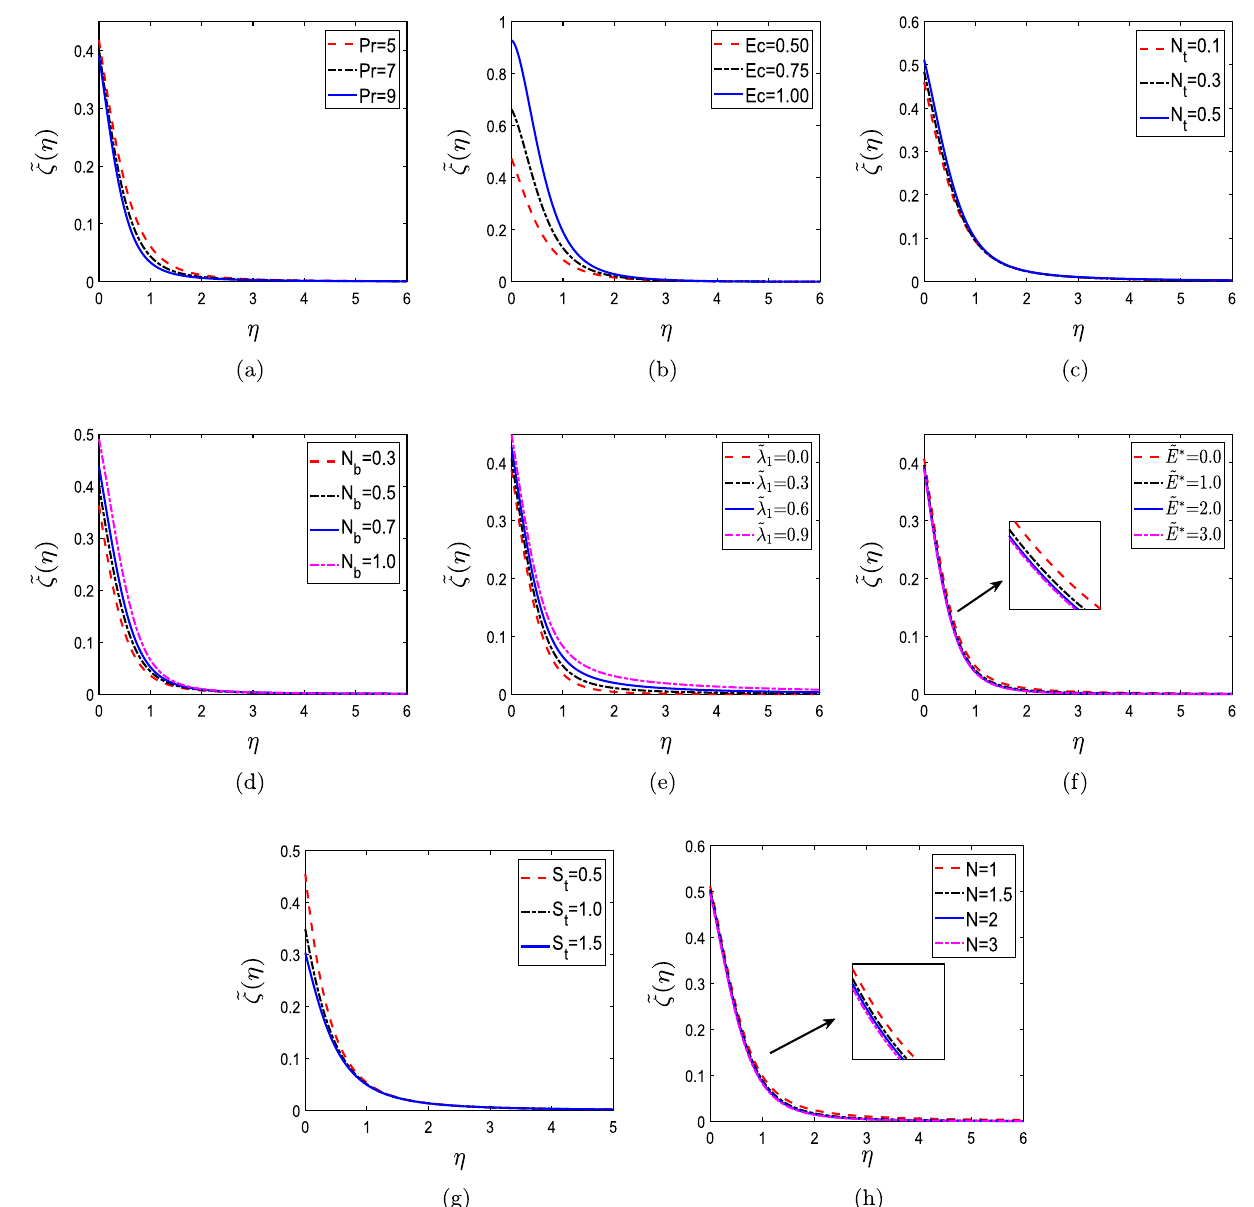
Figure 6. Non-dimensional temperature profiles for ( a ) Prandtl number (Pr), ( b ) Eckert number (Ec), ( c ) thermophoresis parameter ( N t ), ( d ) Brownian motion parameter ( N b ), ( e ) endothermic/exothermic reaction ˜ (cid:31) parameter ( 1 ), ( f ) activation energy parameter (